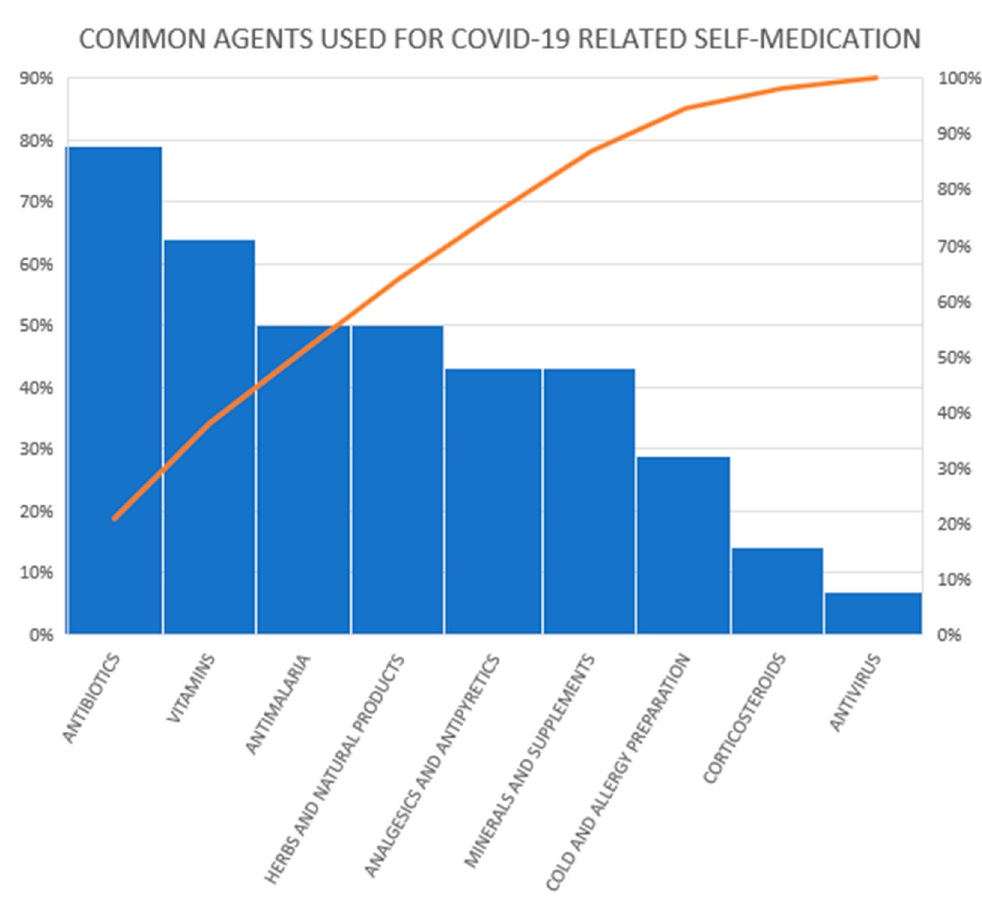
Figure 3. Medicinal agents used for COVID-19-related self-medication in reviewed